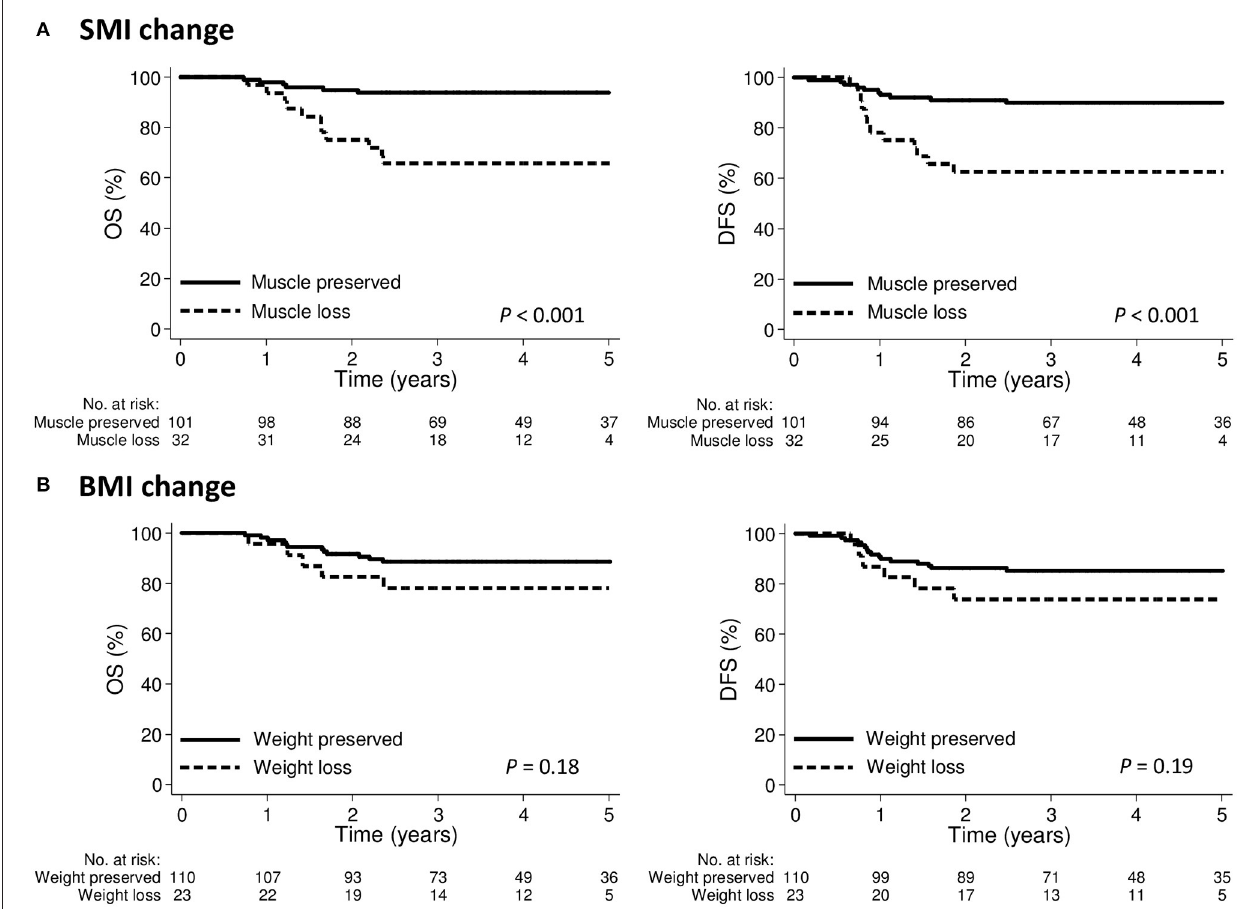
FIGURE 4 | Kaplan-Meier curve demonstrating overall survival and disease-free survival according to (A) SMI change or (B) BMI change groups. BMI, body mass index; SMI, skeletal muscle